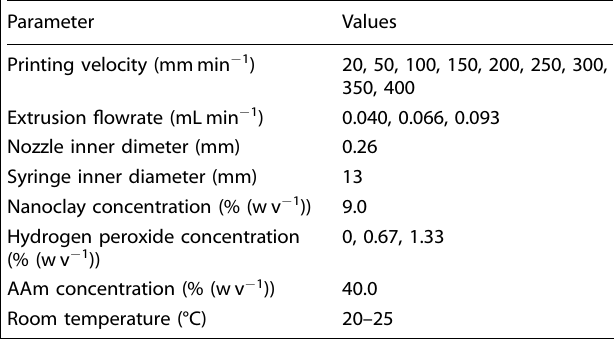
Table 2. Printing parameters used for direct writing of liquid